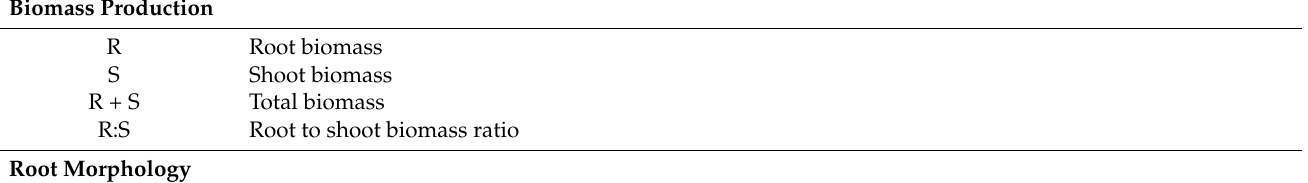
Table 1. Abbreviations and definitions of the measured